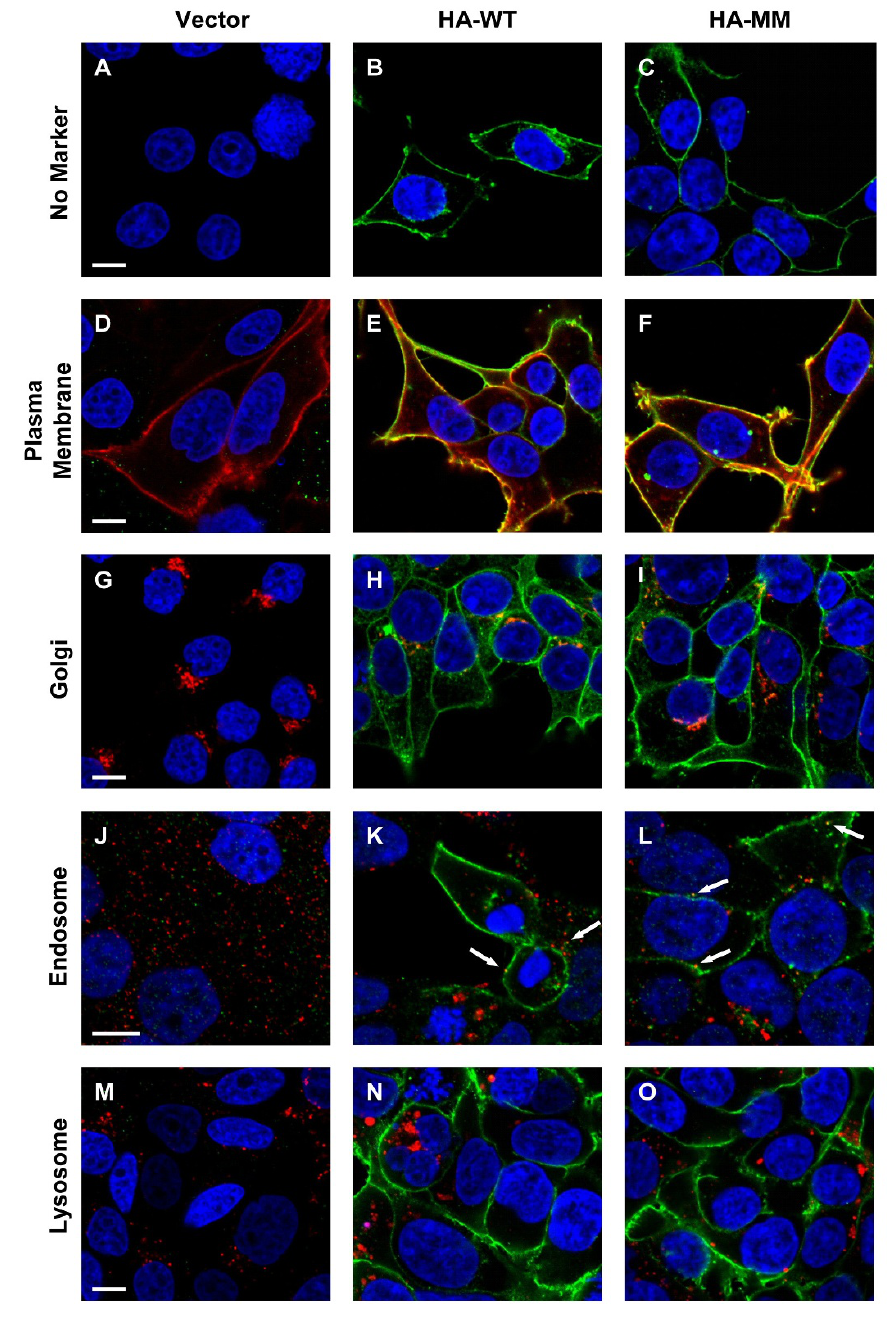
Figure 4 Subcellular localization of HA-tagged ABCA1 in HEK293H cells . HEK293H cells expressing the wild type (HA-WT) or double mutant variant (HA-MM) of HA-ABCA1 were immunostained with anti-HA antibody and visualized by confocal microscopy (green). As a negative control HEK293H cells transduced with the empty vector was used. Various cellular mark- ers (wheat germ agglutinin, anti-Giantin and anti-EEA1 antibodies, as well as LysoTracker) were used to identify the different cell organelles (red), whereas DAPI staining was used to label the nuclei (blue). Both wild type and MM variant of HA-ABCA1 were localized predominantly in the plasma membrane. The minor intracellular staining colocalized primarily with the Golgi marker, and rarely with the endosomes (see white arrows). The scale bars indicate 10 μ